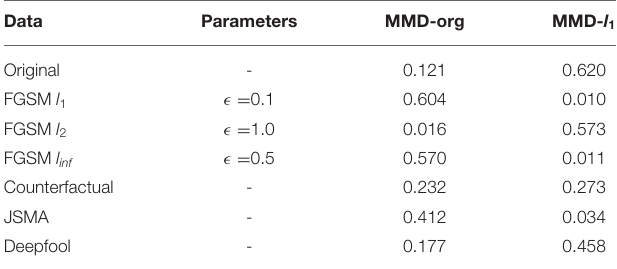
TABLE 2 | MMD between a benign distribution and adversarial distribution on Amazon